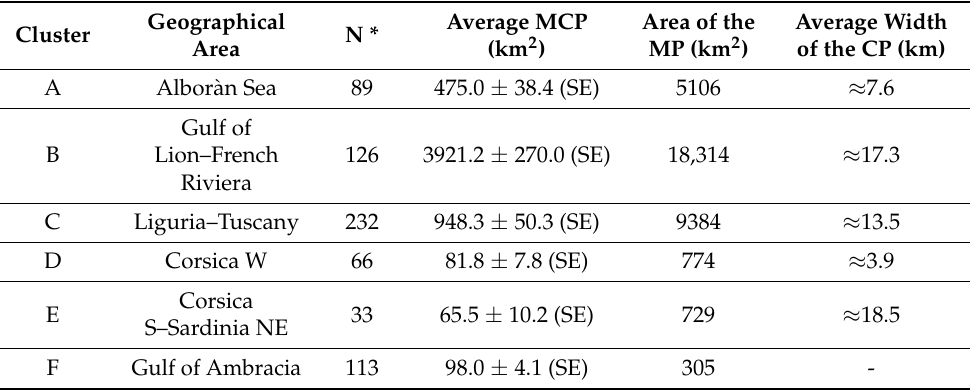
Table 4. The average area (km 2 ) of the individual MCP, the area (km 2 ) of the complex MP and the average width of the continental platform (CP) in the area of occupancy of the related cluster (see also Figure 9). We could not calculate the average CP width for the occupancy area of cluster F, as the Gulf of Ambracia is fully included in the continental platform.